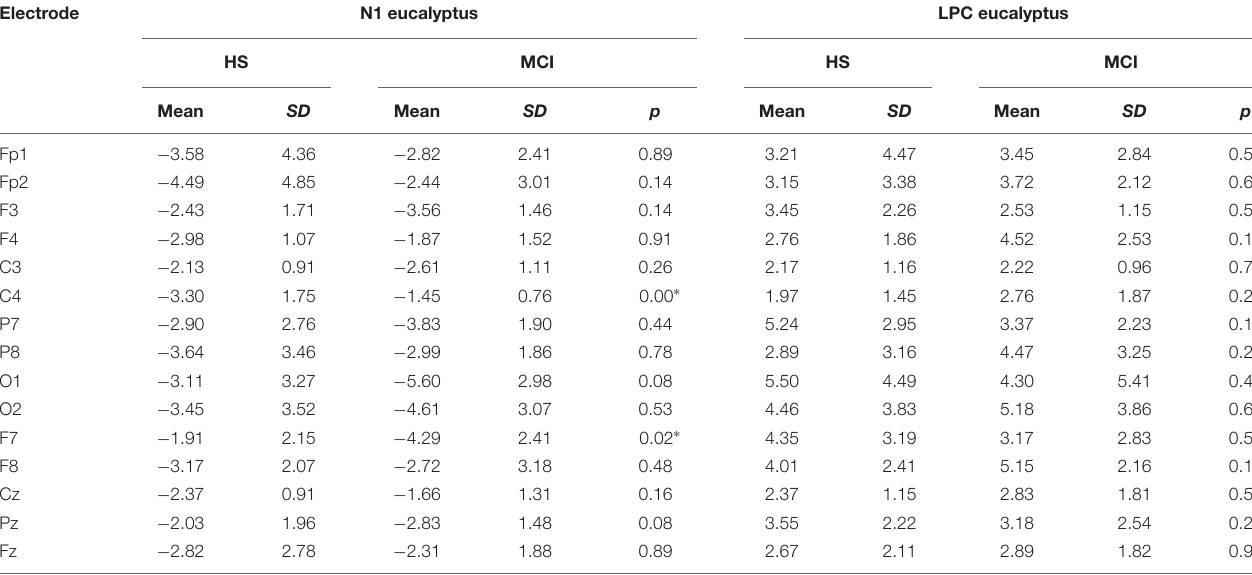
TABLE 3 | Means of N1 and LPC amplitudes ( µ V) elicited by the eucalyptus odorant for MCI and HS groups. Electrode